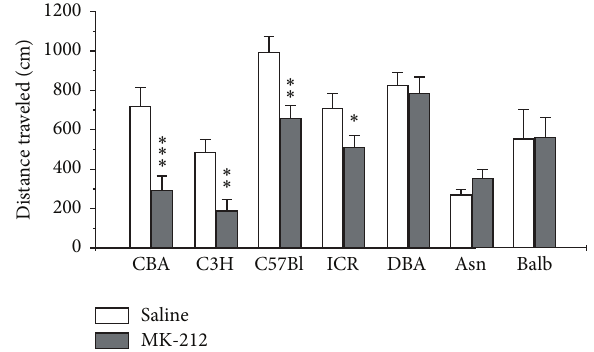
Figure 3: Effect of selective 5-HT 2 C receptor agonist MK-212 (2mg/kg, i.p.) on locomotor activity in the open field test in seven inbred mouse strains. The data are presented as mean ± SEM ( 𝑛 = 8 per group; ∗ 𝑝 < 0.05 , ∗∗ 𝑝 < 0.01 , and ∗∗∗ 𝑝 < 0.001 compared with corresponding